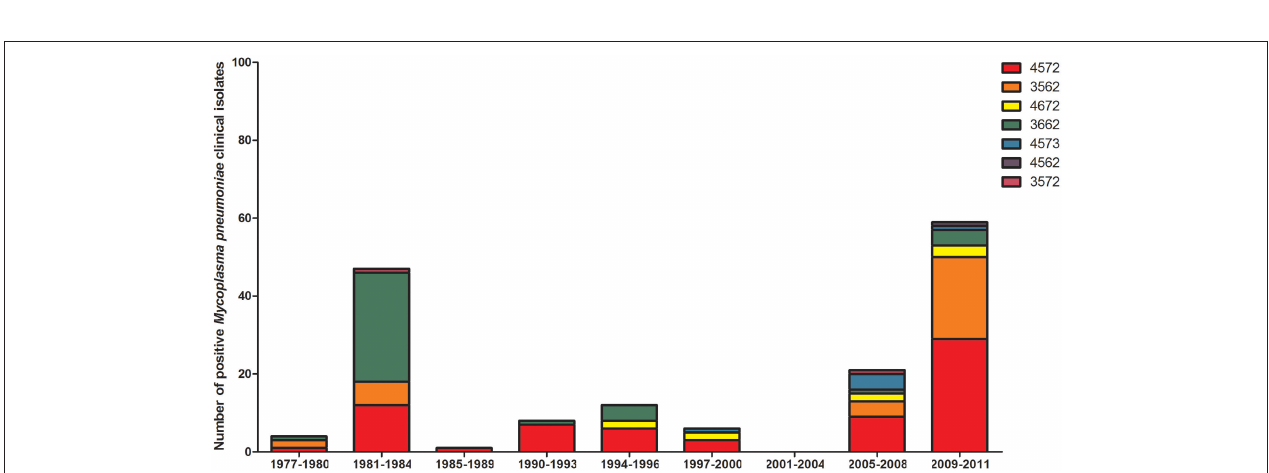
FIGURE 3 | Distribution of MLST sequence types for 57 M. pneumoniae clinical isolates in the 4-yearly epidemic cycles observed in the UK. Year groups indicative of epidemic periods are listed on the x -axis. Sequence types (ST) 1–12 are listed in the key and indicated with differing colors. Allelic profiles are available on http://pubmlst.org/mpneumoniae.